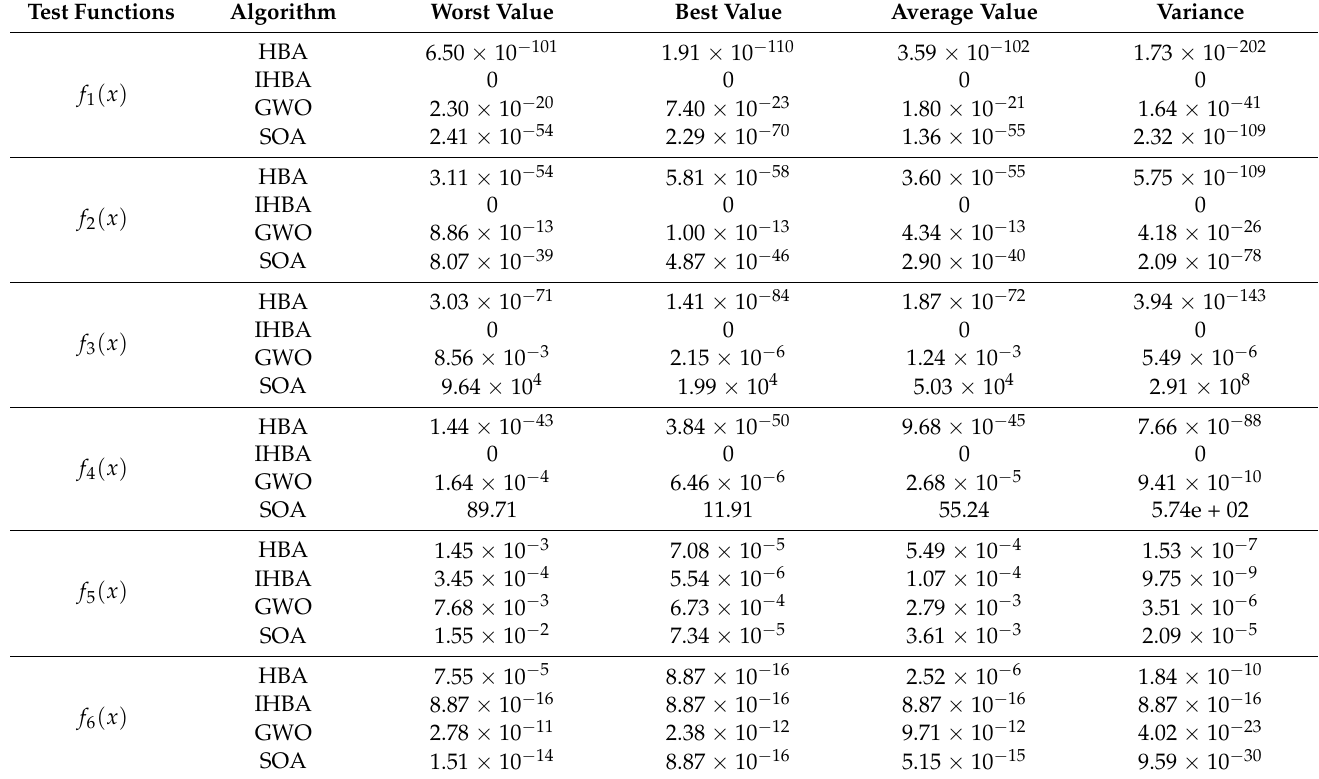
Table 2. Test results of the